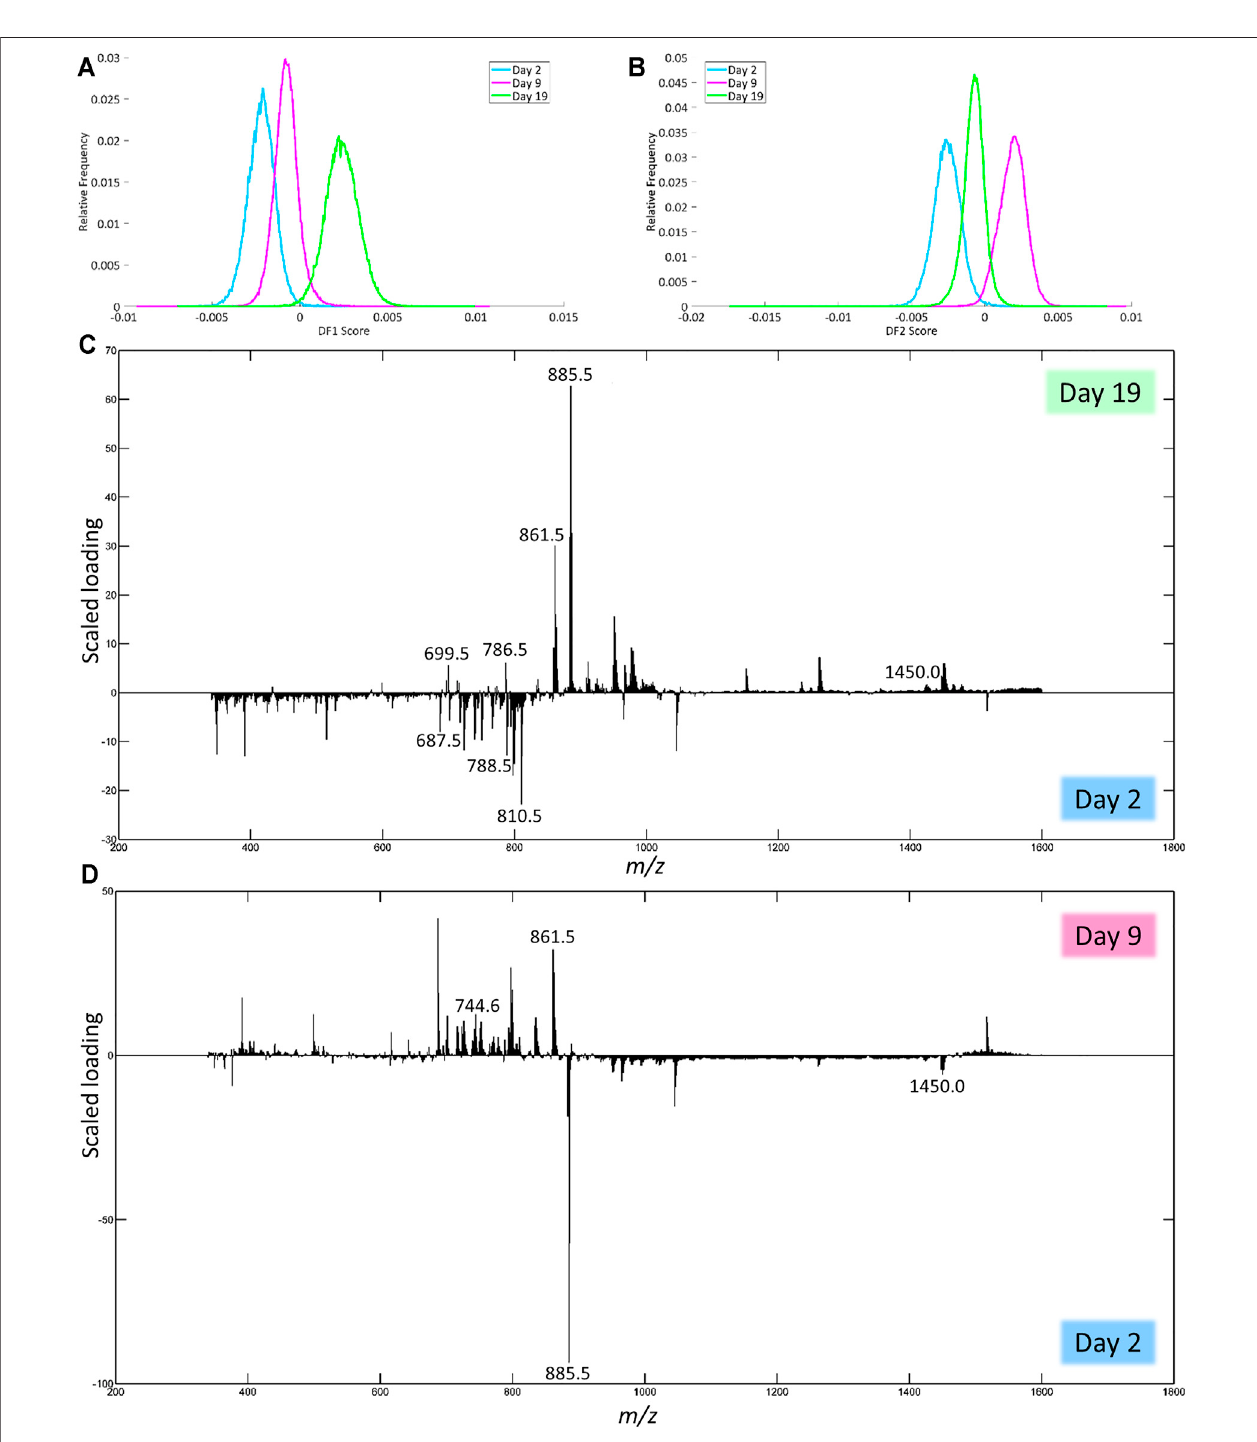
FIGURE 5 | Results of the PCA-LDA of the human fxh of different fxh age (2, 9, and 19 days) for negative ion mode. DF-scores and their corresponding scaled loadingplotsareshown.Thescaledloadingisacombinationoftheintensityofthe m/z valuewithhowmuchthemoleculecontributestotheseparationofclassesacross the speci fi ed discriminantfunction. The positive side for the DF-score plot is related to the positive side of the scaled loading plots. This indicates that the m/z values at a certainsidehaveahighercontributionintheclassatthatside. (A) DF-1scorerepresentingthe fi rstdiscriminantfunction,whichcorrespondstothehighestvariance inthedataset. (B) TheDF-2scorerepresentingtheseconddiscriminantfunction. (C) ScaledloadingplotofthefullmassrangeforDF-1. (D )Scaledloadingplotofthefull mass range for DF-2.